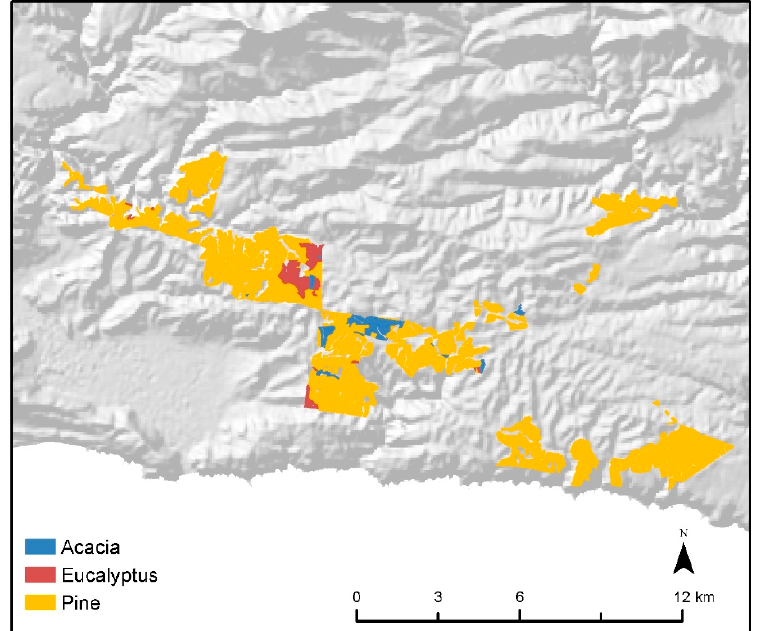
Remote Sens. 2022 , 14 , x FOR PEER REVIEW Figure 3. In situ data of genus distribution in Study Area 1. Figure 3. In situ data of genus distribution in Study Area 1.